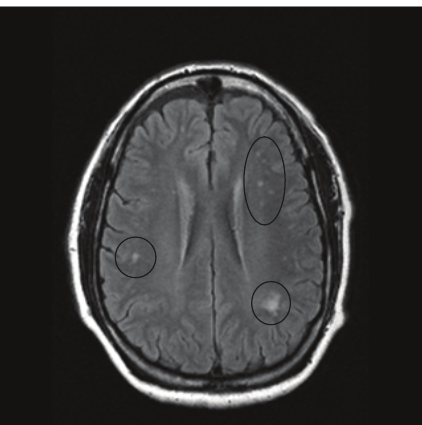
Figure 3: MRI image of the brain in an axial view showing the “pre- contrast T2 image”. Note the abnormal lesions (circled) in the per ventricular area suggesting white matter